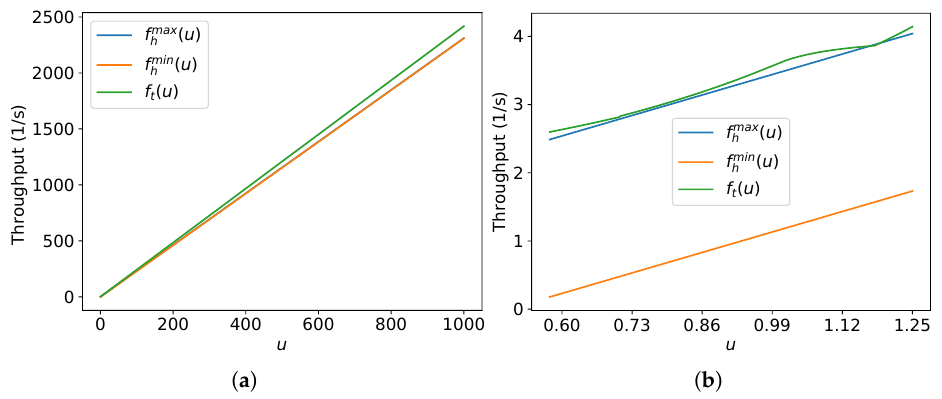
Figure 18. Graph varying u for f min intervals of u . In ( a ), f min except in an interval within (1.12,1.25). ( a ) u ∈ [1 /